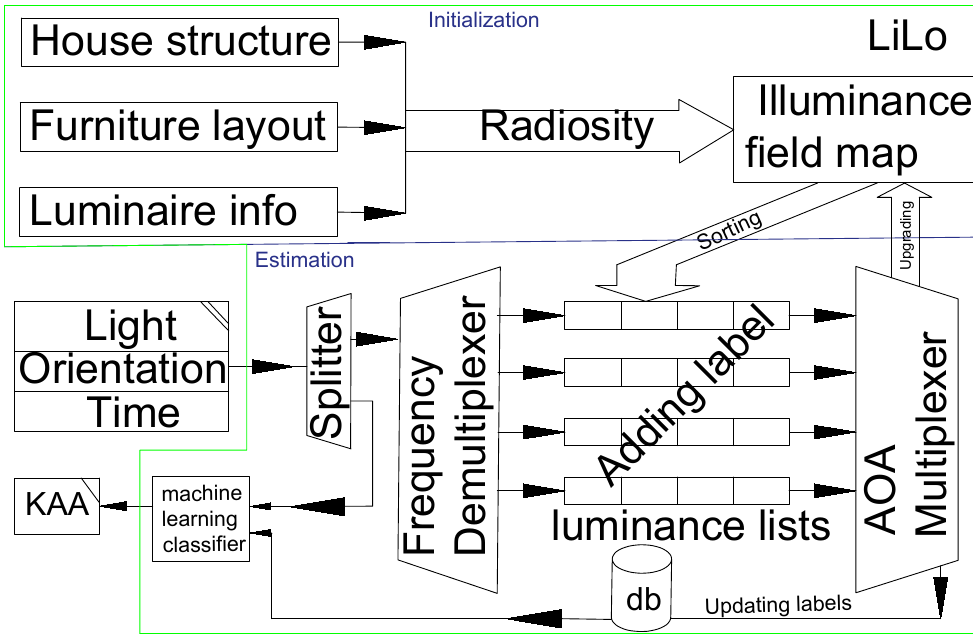
Figure 4. The system architecture of